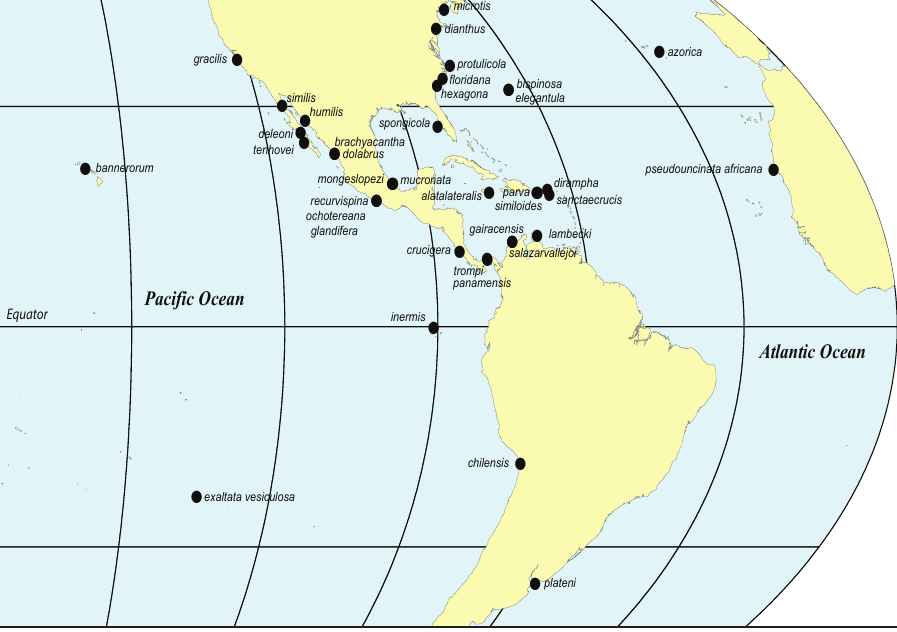
Figure 2. Hydroides species type localities of the Western Hemisphere (Americas and Eastern Pacific). Labels are current species-group names. Map grids 30°